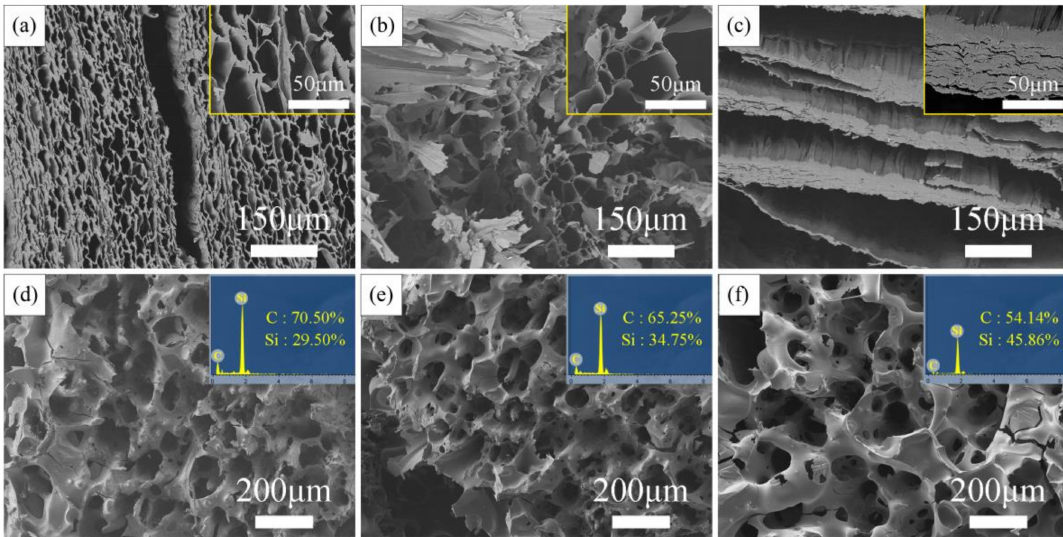
Figure 3. Morphology of the biotemplates from NaOH Method ( a ), NaClO 2 Method ( b ),